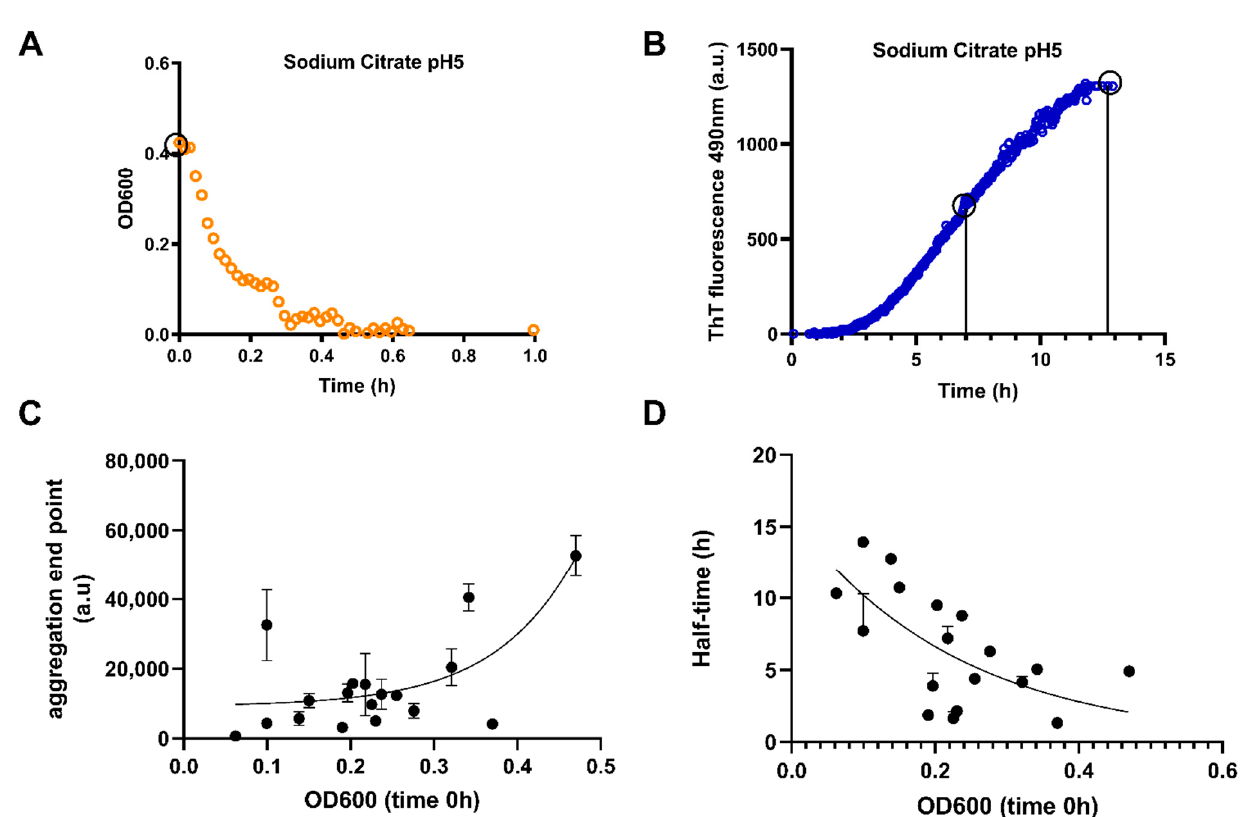
Figure 2. Determination of the TDP-43 LCD behavior in a variety of buffers belonging to the Hofmeister series ( A – D ). Representative examples of the two assays that were used to determine the behavior of TDP-43 LCD buffer screen. The measurement of the OD600 was used to determine the level of initial LLPS ( A ), and determination of ThT fluorescence at 490 nm was indicative of amyloid aggregation ( B ). The assays show the behavior of TDP-43 LCD (20 µ M) in one buffer, sodium citrate 25 mM at pH 5.0. Based on similar measurements of ( A , B ), use of time 0 OD600, half-time of aggregation curve (using EC50 of dose–response curve fit), and aggregation end-points for each buffer belonging to the Hofmeister series were obtained as shown in Supplementary Figure S2. ( C ) Data showing mean aggregation end-point versus mean OD600 at time 0 for 18 different buffers belonging to the Hofmeister series ± SD. ( D ) Half-time (EC50) of ThT fluorescence versus mean OD600 value at time 0 was plotted ± SD. Where error bars are not depicted, error was too low to plot. Black circles on graphs in panels ( A , B ) show how the values used for ( C , D ) were obtained. ( C , D ) fitted using non-linear sigmoidal dose–response (variable slope).